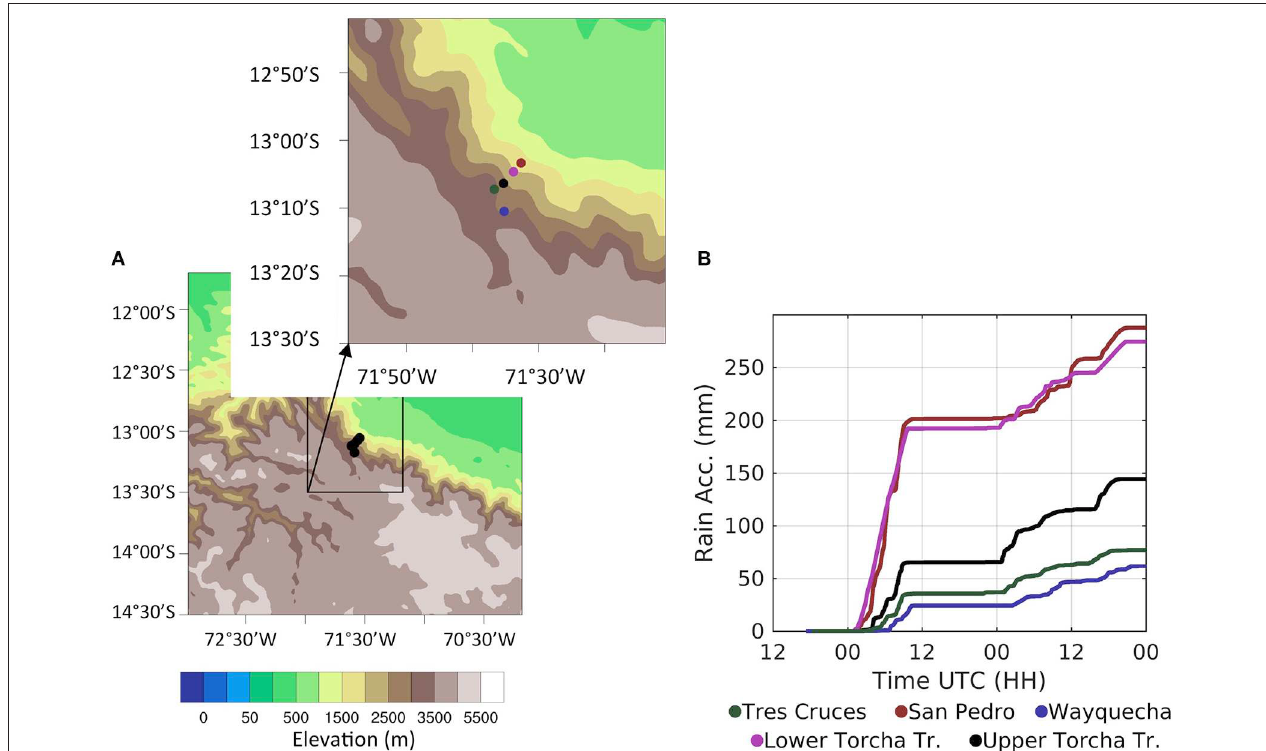
FIGURE 1 | (A) Location of the rain-gauges used in this study and Madre de Dios Transect (inset) in the Peruvian Andes. (B) Cumulative rainfall curves (CRCs) from 2013-10-03 12:00 Local Time (LT) to 2013-10-06 00:00 LT for all rain-gauges. The CRC color is the same as the corresponding rain-gauge mark in the inset map.